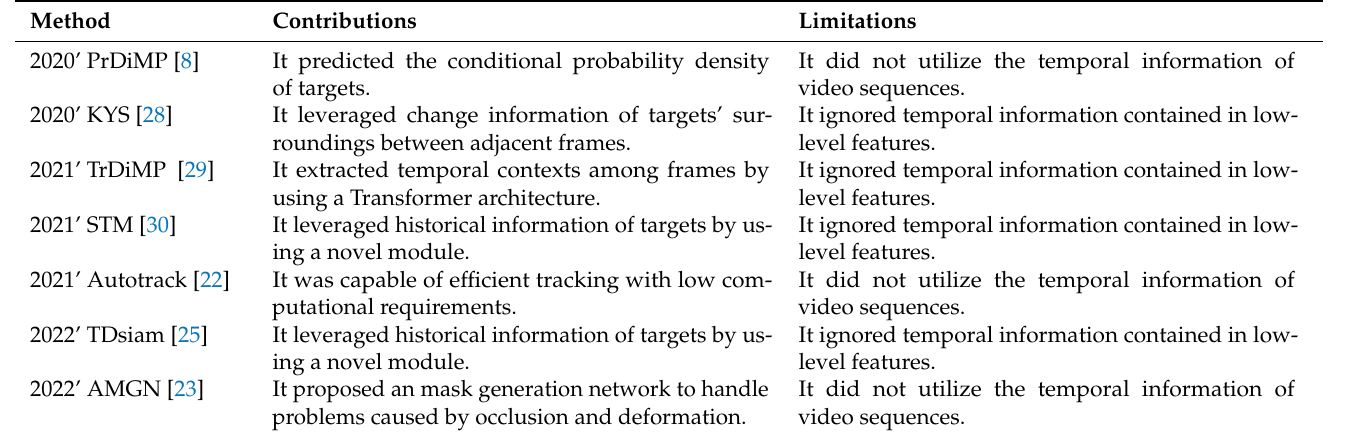
Table 1. Contributions and limitations of some most recent relevant